Question: Summarize what this figure shows in one sentence.
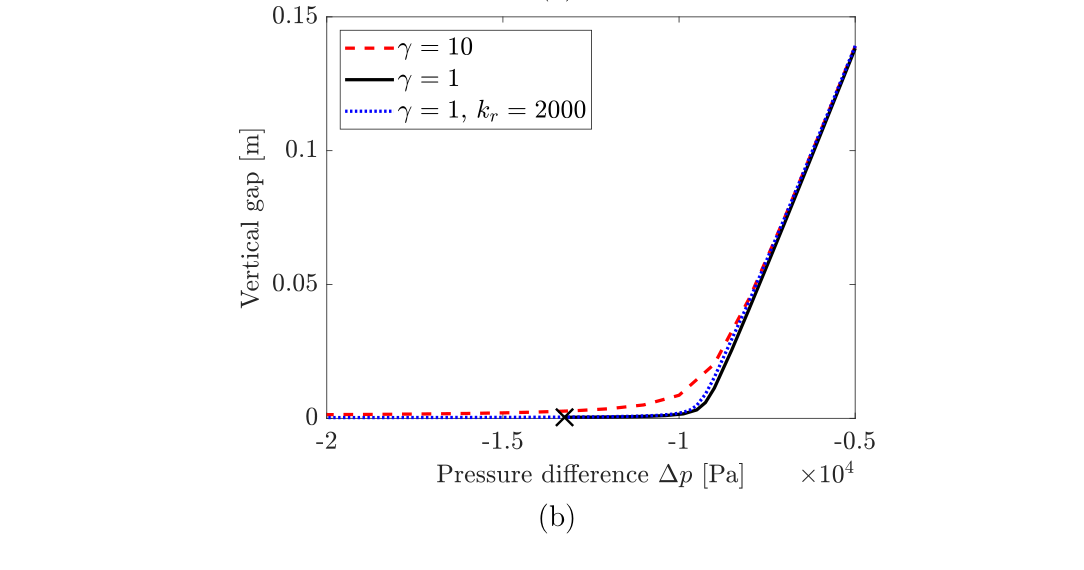
Answer: Simulation of monotone suction in a single pneumatic cell. (a) Mesh and deformed configuration for γ = 10 (left), for γ = 1 (center), where only the last converged configuration is shown, with contact penetration and distorted third medium, and for γ = 1 with the use of additional regularizing terms (right). (b) Comparison of pressure-gap diagrams for different values of γ and regularization (only relevant area shown).